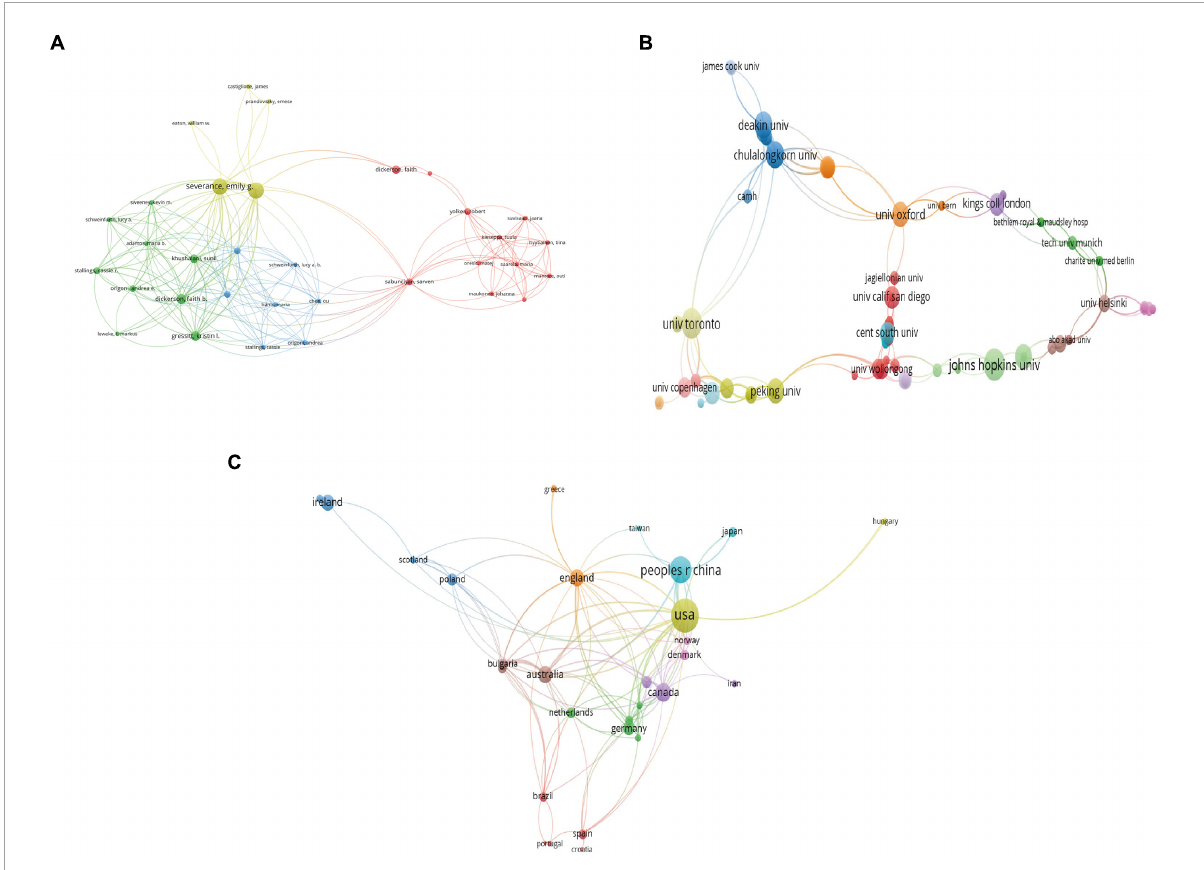
FIGURE3 Visualization knowledge maps of the co-authorship. (A) Authors. (B) Organizations. (C)